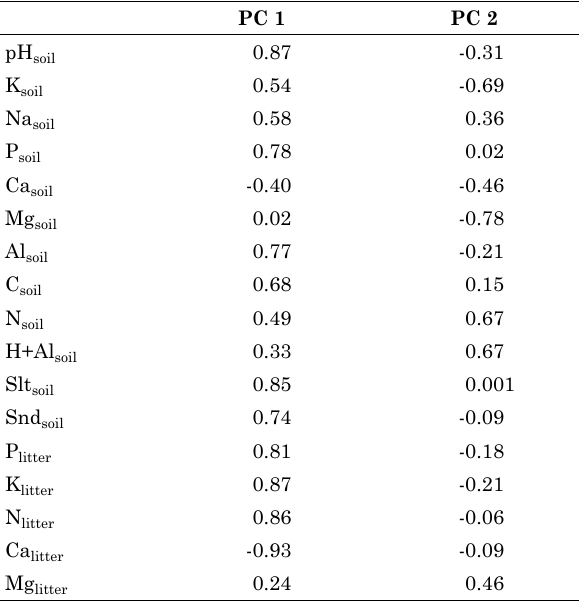
units and descriptors in the reduced space of the first two components. Sampling units of sites a and b are represented by black and gray dots, respectively. the ellipses indicated by capital letters a and b further show the differentiation between the two areas. litter properties are identified by an asterisk